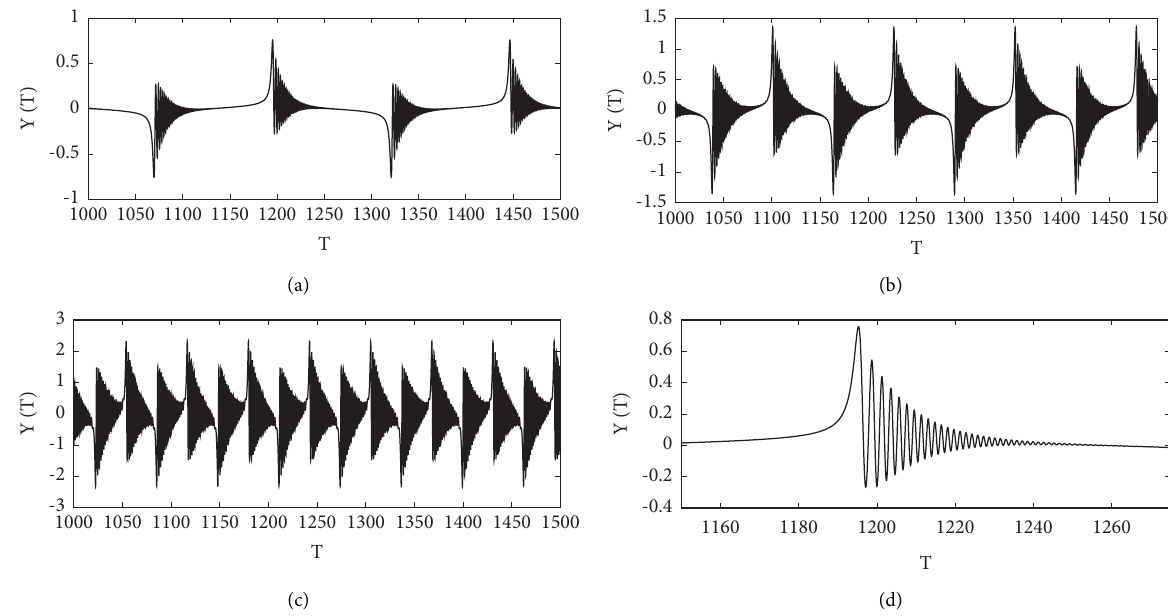
Figure 8: Chaotic busting oscillations in the system for the parameters F � 27, ξ � 0 . 1, and α � 0 . 675: (a) ω � 0 . 025; (b) ω � 0 . 05; (c) ω � 0 . 1 ; (d) the zoom view of